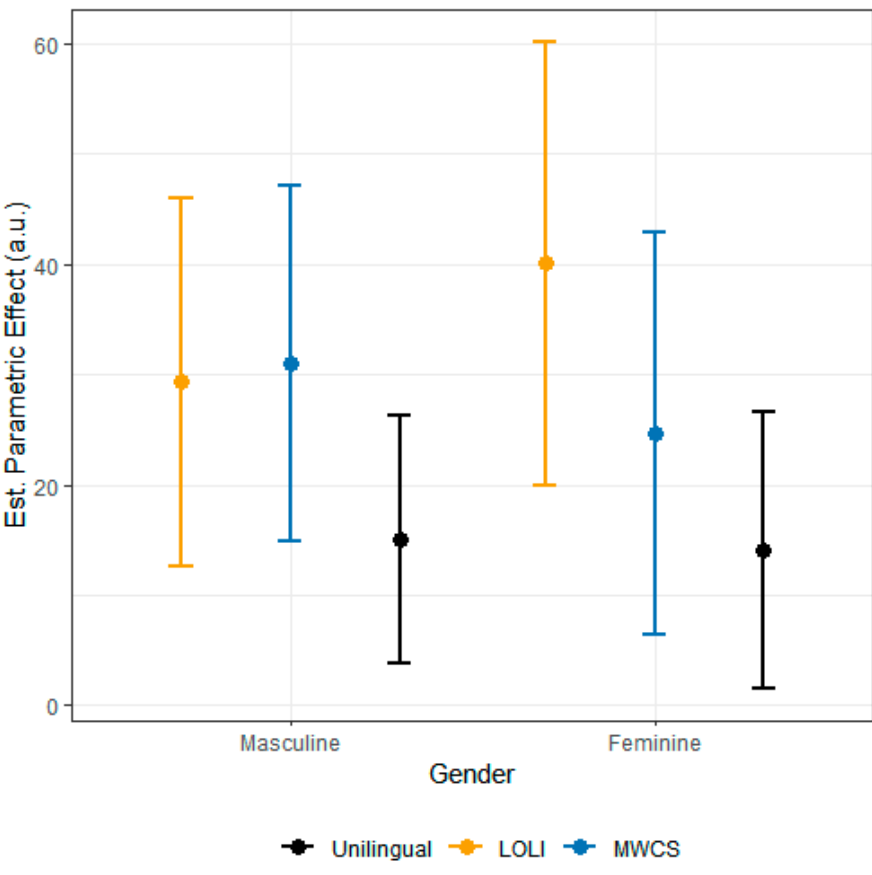
Figure 3. Fitted parametric (intercept) values.